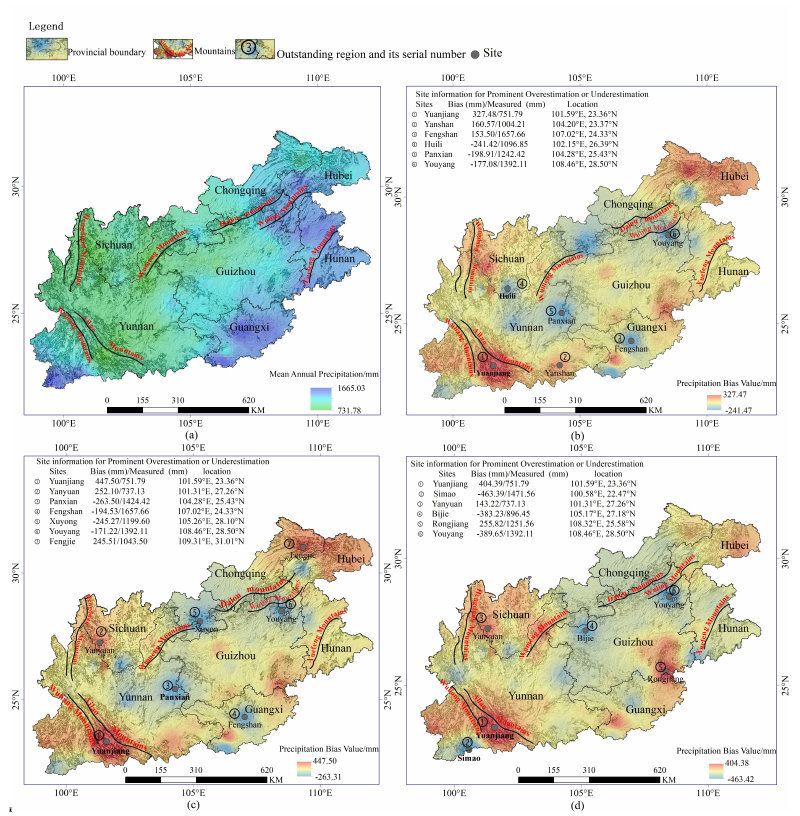
Figure 9. Spatial Distribution Map of ( a ) the Mean Annual Precipitation and Corresponding Precipi- tation Bias of the Three Products: ( b ) CMFD, ( c ) TRMM 3B42 and ( d )